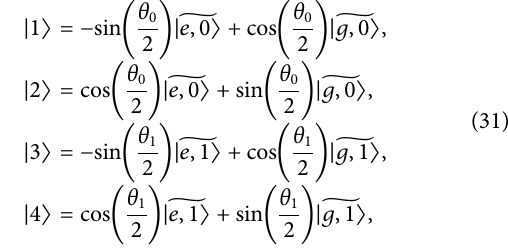
Frontiers in Physics |